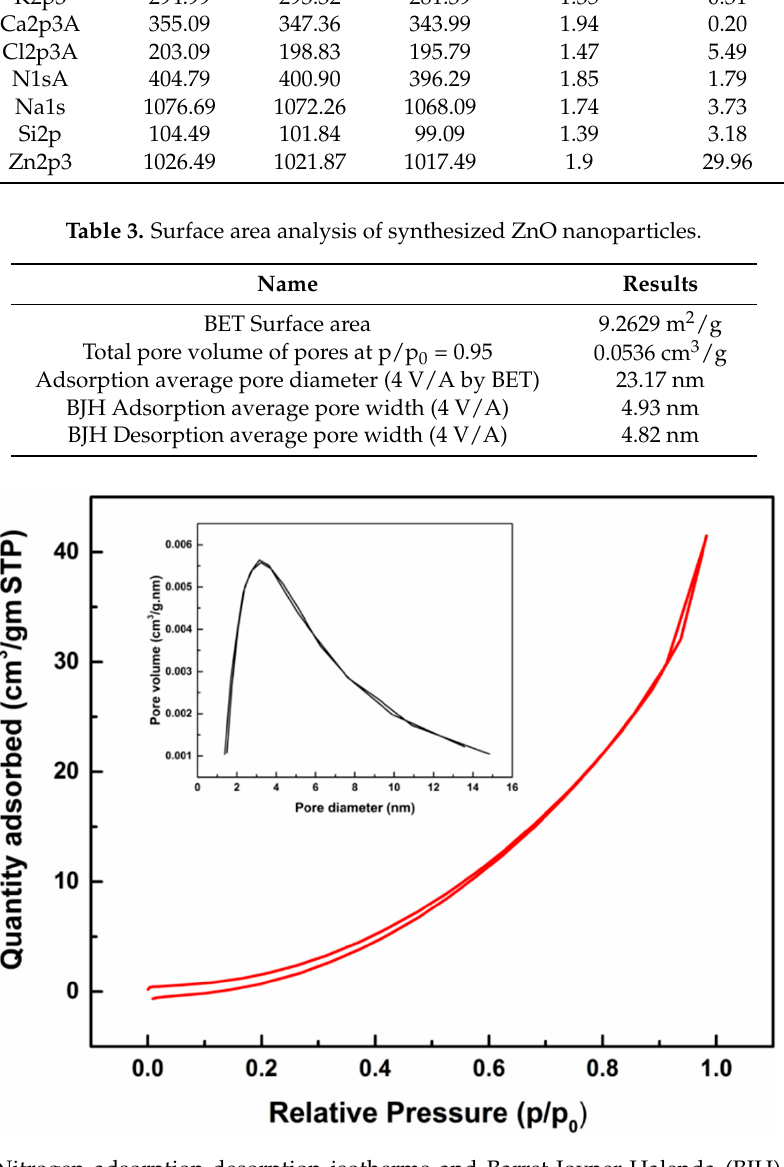
Figure 7. Nitrogen adsorption-desorption isotherms and Barret-Joyner-Halenda (BJH) pore size distribution (inset) of as-synthesised ZnO nanoparticles.